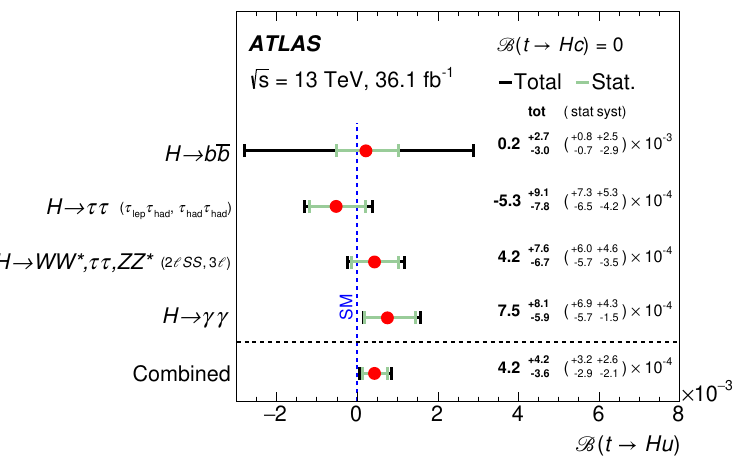
Figure 12 . Summary of the best-(cid:12)t B ( t ! Hu ) for the individual searches as well as their combination, assuming B ( t ! Hc ) =